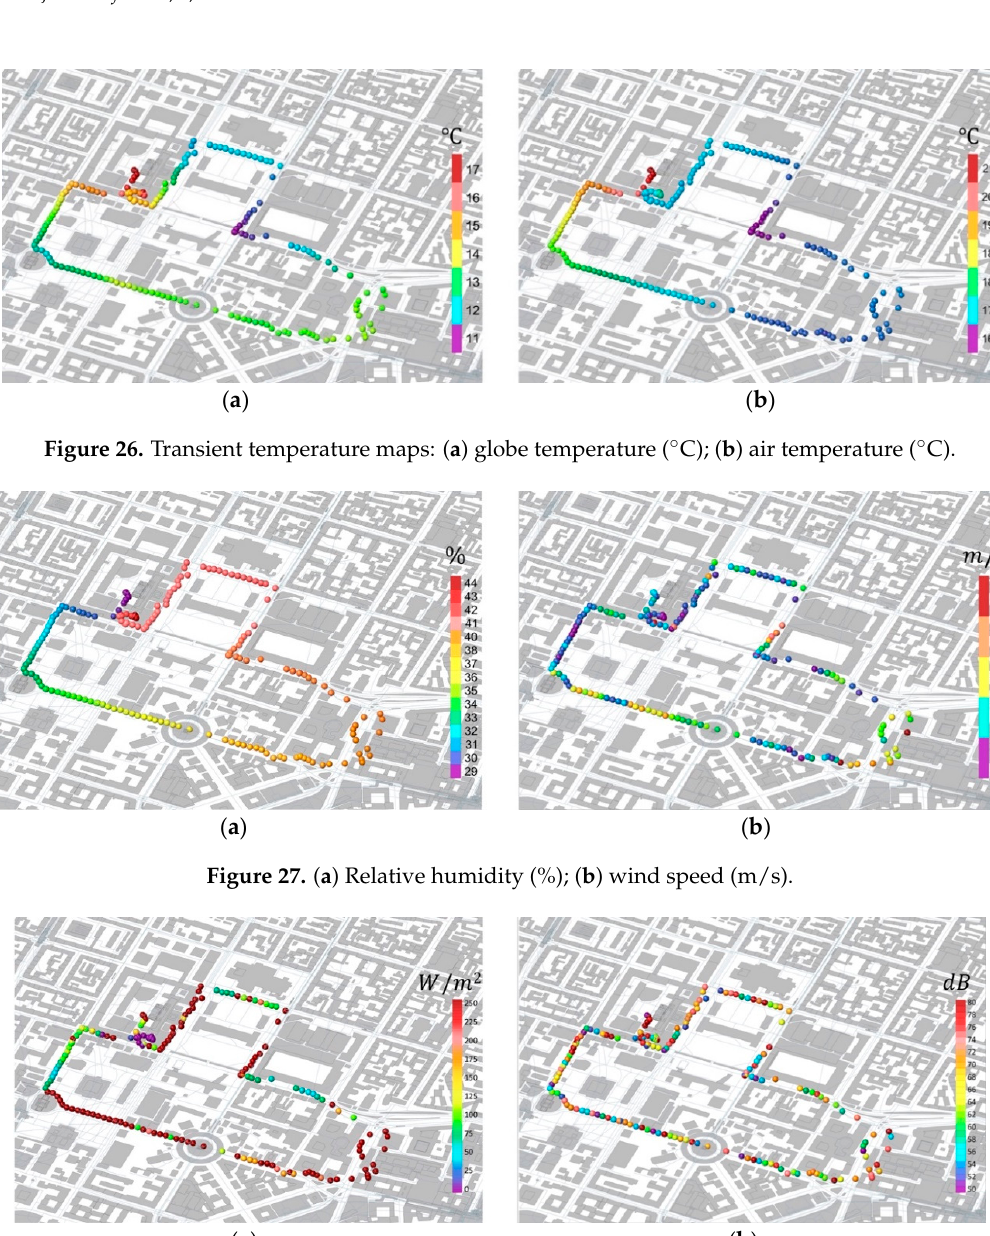
ISPRS Int. J. Geo-Inf. 2019 , 8 , 76 20 of 24 ( a ) ( b ) Figure 23. ( a ) Region of assessment in city of Munich; ( b ) the route. ( a ) ( b ) Figure 24. ( a ) Figure ground map; ( b ) GPS signals over the path.